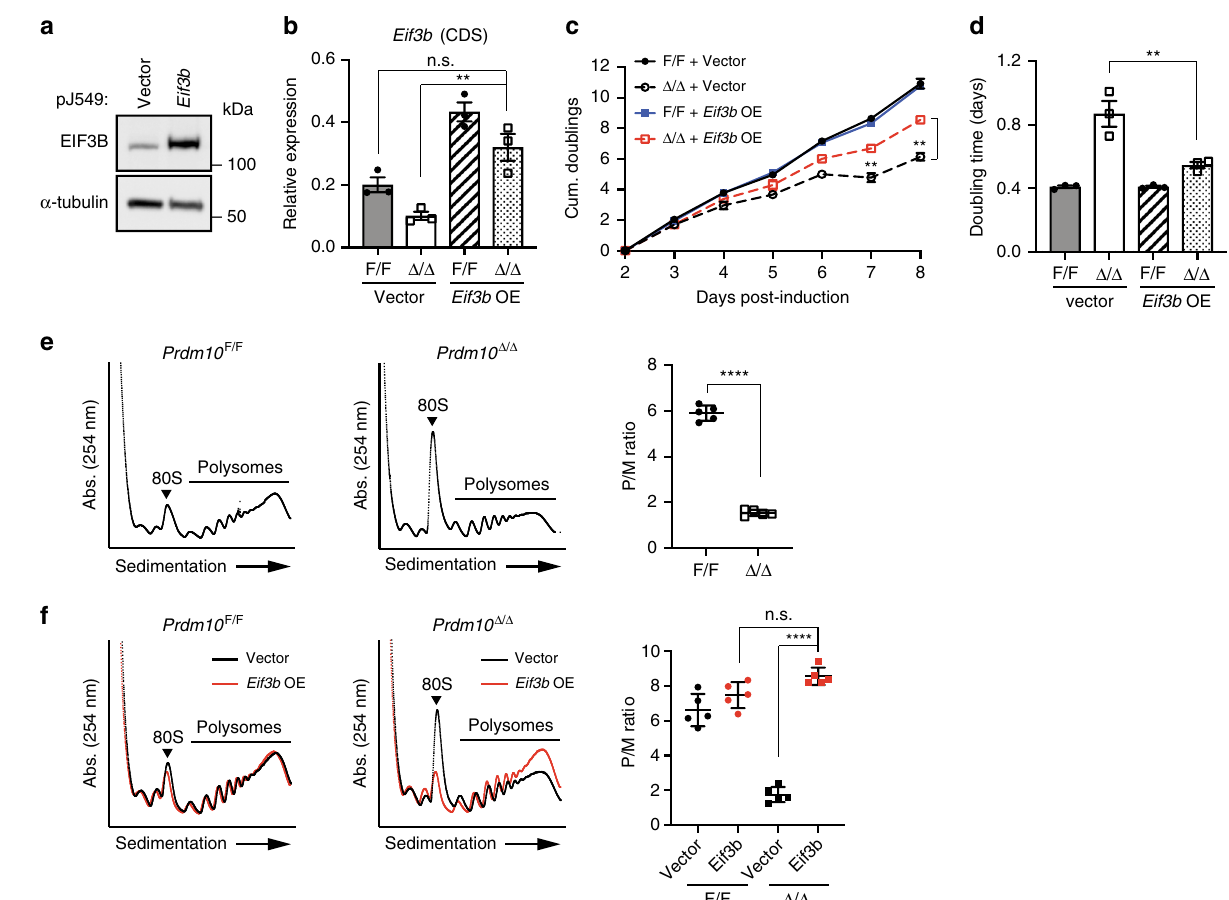
Fig. 6 EIF3B promotes global translation downstream of PRDM10. a Immunoblotting detection of FLAG-tagged EIF3B protein expression in Prdm10 F/F ; CreER T2 mESCs transformed with pJ549- Eif3b or vector. b qRT-PCR validation of Eif3b transcript in Prdm10 F/F ; CreER T2 mESCs transformed with pJ549- Eif3b or vector, analyzed 6 days post-induction. CDS-speci fi c primers were used to detect both endogenous and overexpressed Eif3b transcript; n = 3 biological replicates. c Growth curve analysis of Prdm10 F/F and Prdm10 Δ / Δ mESCs in the presence of empty vector or exogenous Eif3b , showing